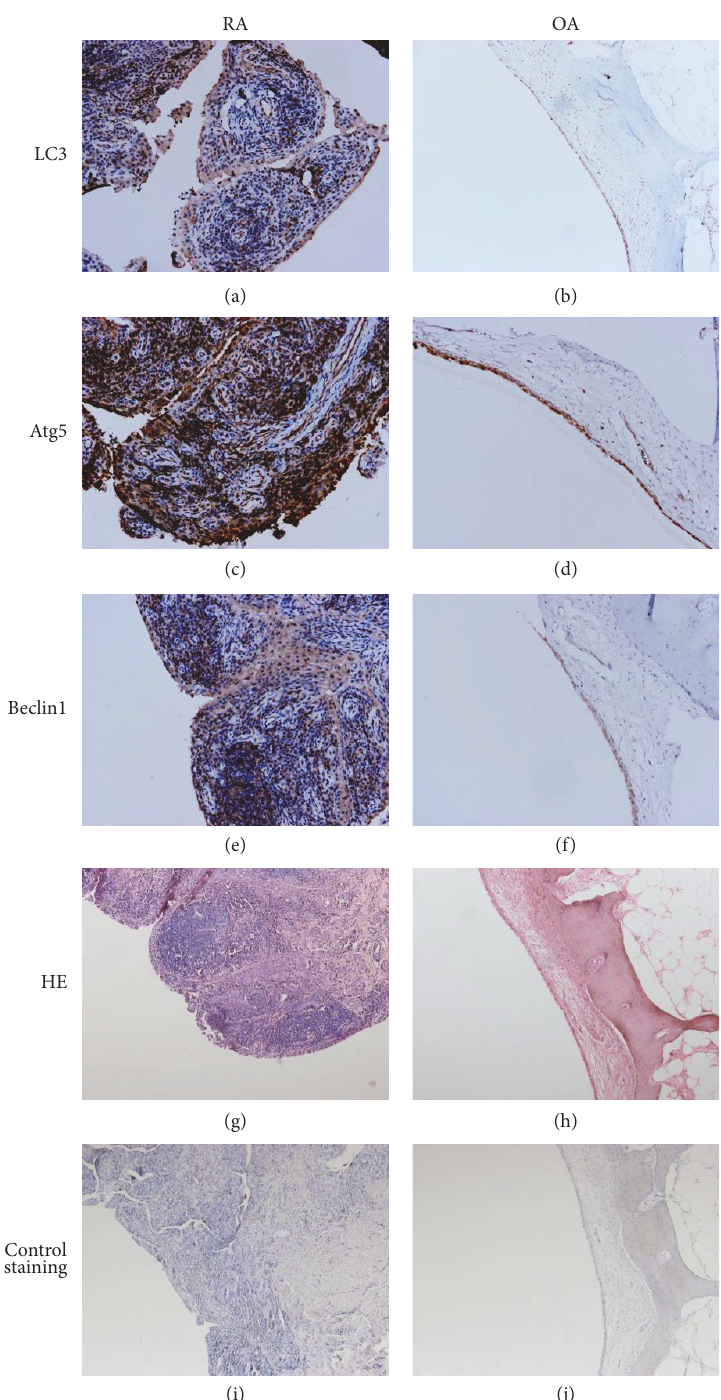
Figure 2: Localization and expression level of beclin1, Atg5, and LC3 in RA synovial tissues. Immunohistochemical analyses of beclin1, Atg5, and LC3 localization in RA synovium. Synovial tissues from RA and OA patients were stained with anti-beclin1 antibodies (a and b), anti-Atg5 antibodies (c and d), anti-LC3 antibodies (e and f), H&E staining (g and h), or anti-rabbit IgG antibodies as a nonimmune control (i and j). Magnification